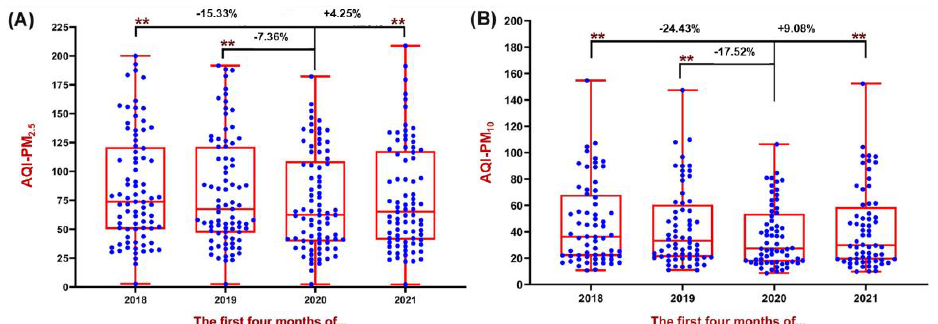
Figure 3. Percentage change of AQI PM 2.5 , PM 10 , NO 2, , and SO 2 between 2020 — during the lockdown period — 2019, and 2021, in different cities worldwide. ( A ) AQI – PM 2.5 variation, (B ) AQI – PM 10 vari- ation. Reproduced from Ref. [104] with permission. Copyright, Copyright, 2022, Springer Nature.